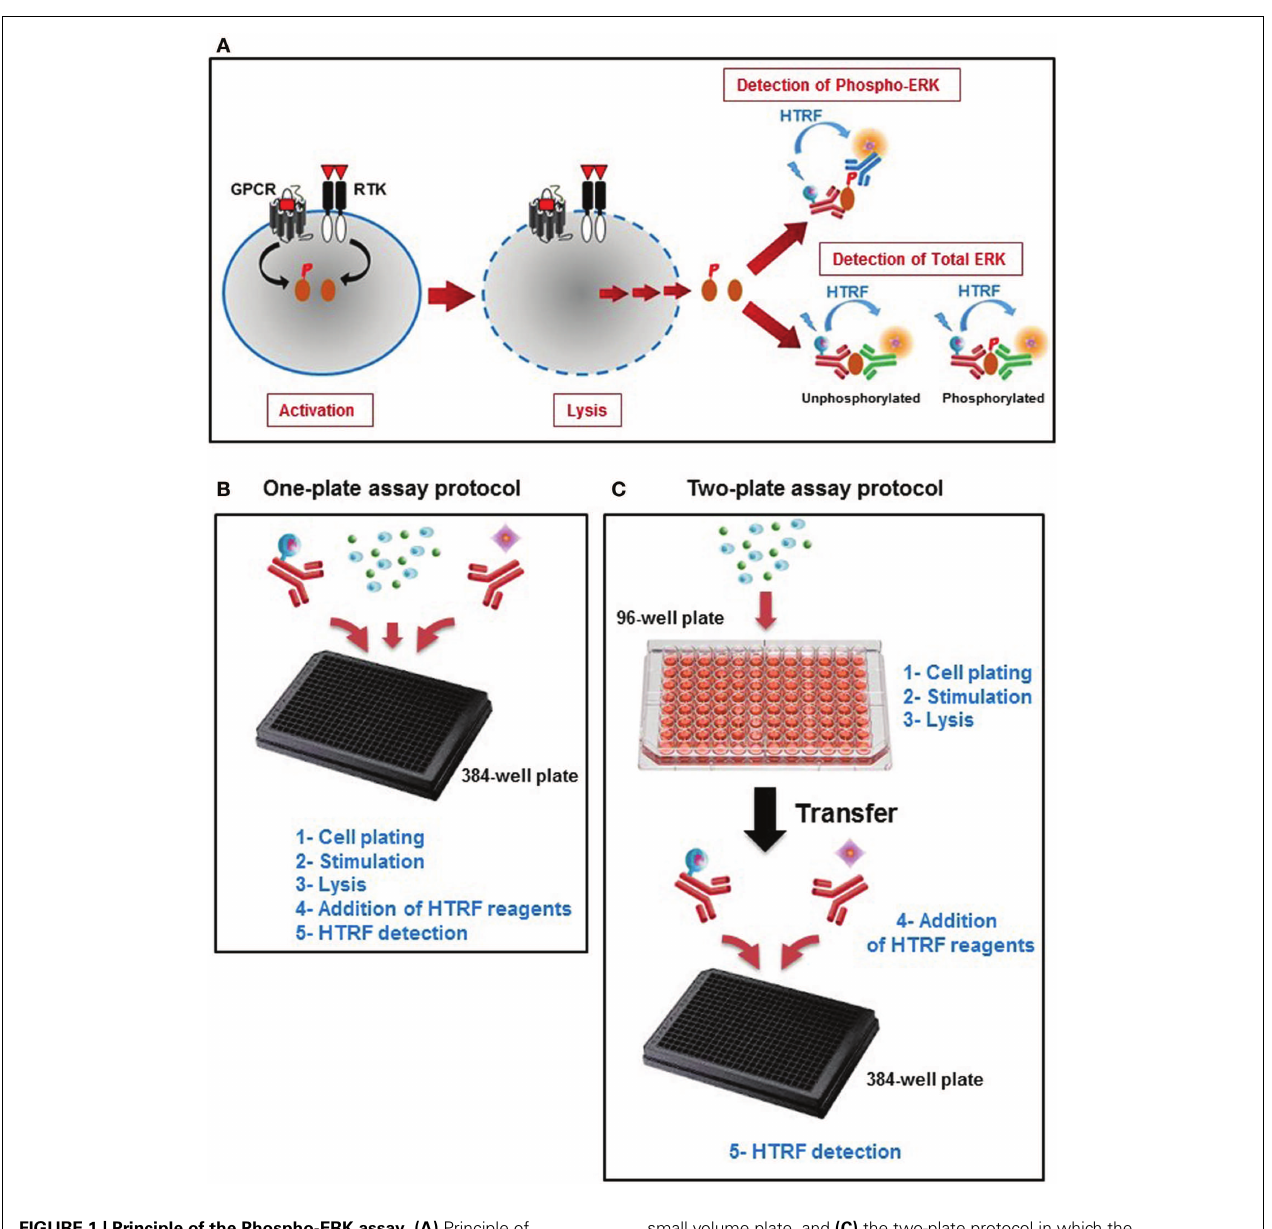
FIGURE 1 | Principle of the Phospho-ERK assay . (A) Principle of HTRF ® -based ERK1/2 assay that consists of three experimental steps: activation, cell lysis, and HTRF detection to quantify the total ERK1/2 as well as the phosphorylation of ERK1/2 mediated by the major cell surface receptors.This straightforward assay has been developed with two different protocols: (B) the one-plate protocol where all the assay steps are performed in the total volume of 20 µ l using one 384-well